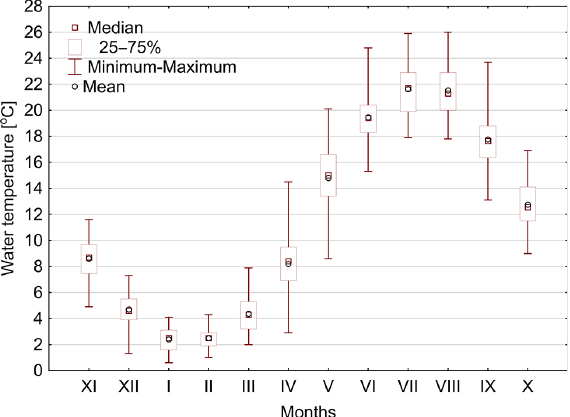
Fig. 2. Hourly changes of the lake’s water temperature in individual